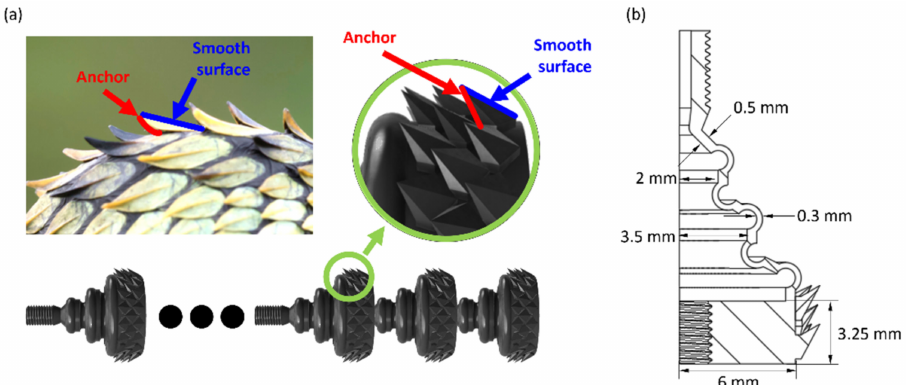
Figure 1. Schematic of MSSR. ( a ) MSSR’s structure inspired by Bush viper’s distinct keeled scales. (Photo courtesy of Mark Kostich, Adobe Stock images). ( b ) Cross-section (axial symmetry) and parameter values of soft actuator design for DLP 3D printing without supporting